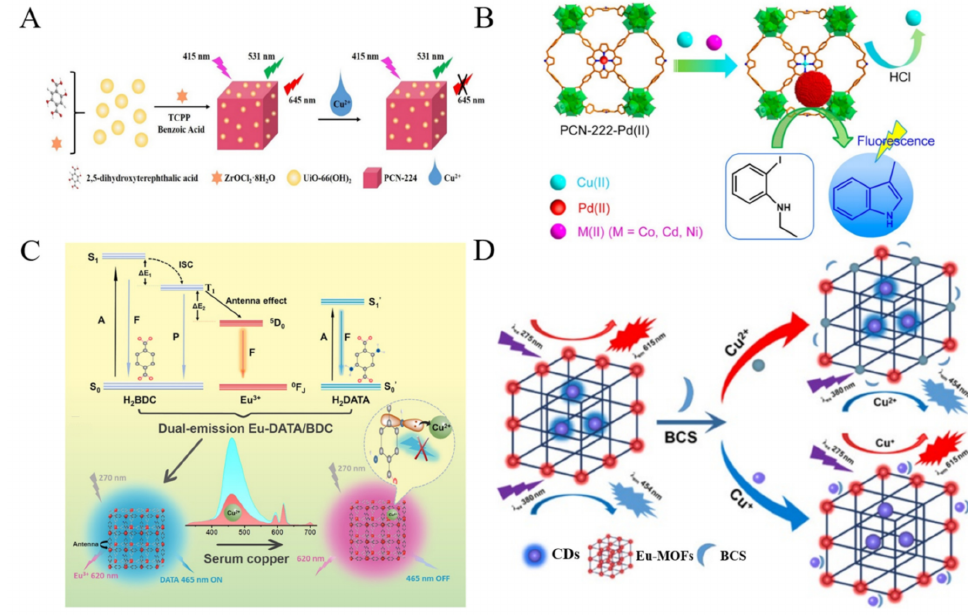
Figure 2. ( A ) Schematic illustration of process for encapsulating the UiO-66(OH) 2 into the porphyrin MOFs (PCN-224) and concept for sensing Cu 2+ . Reproduced with permission [63]. Copyright 2019, American Chemical Society. ( B ) Schematic illustration of the fluorescence “turn-on” sensing of Cu 2+ ions based on the porphyrinic MOFs-catalyzed Heck reaction. Reproduced with permission [65]. Copyright 2016, American Chemical Society. ( C ) Schematic illustration of the design principle of dual-emission Eu-DATA/BDC MOFs and the ratiometric sensing and visible detection of Cu 2+ ions in human serum. Reproduced with permission [66]. Copyright 2022, Elsevier. ( D ) Schematic illustration of the detection mechanisms for Cu + ions and Cu 2+ ions with the dual fluorescence Eu-MOFs@CDs. Reproduced with permission [67]. Copyright 2022, American Chemical